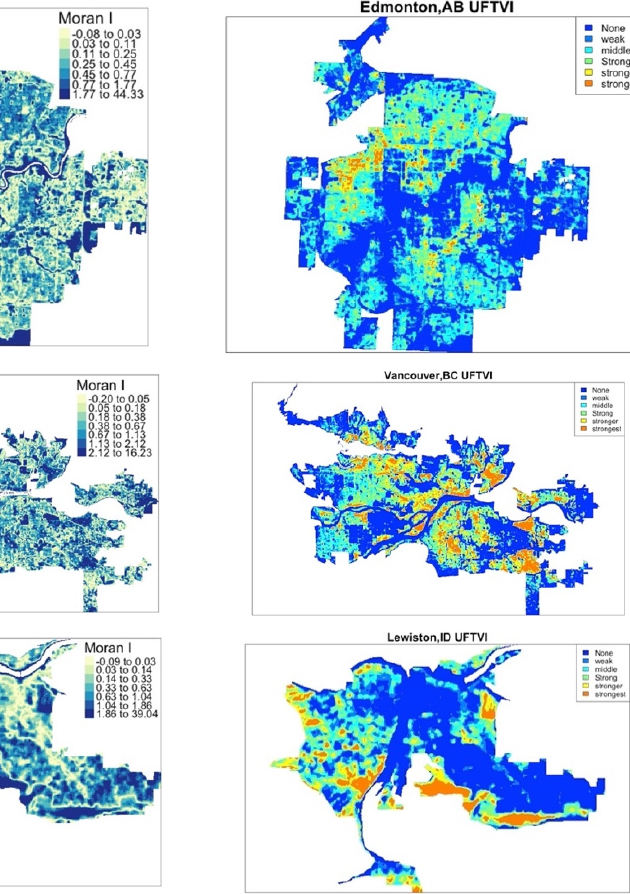
Figure 6. Spatial patterns of LST, Local Moran’s I (MLI), and UFTVI using Landsat-8 data over the cities of Fort McMurray, Edmonton, Vancouver, and Lewiston.